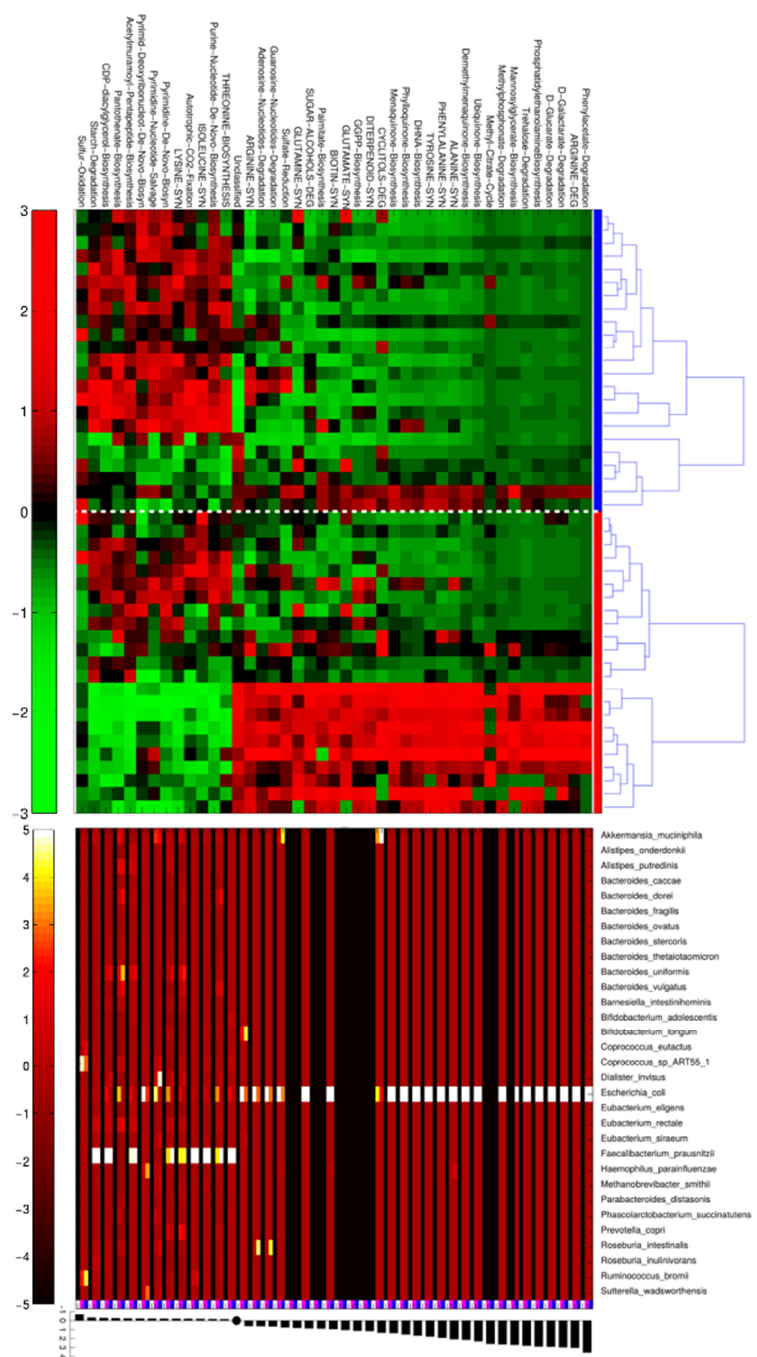
Figure 3. Metagenomic pathways and bacterial genera more expressed with +IMT/+SCA. Heatmap on top shows the MetaCyc L4-pathways statistically different between +IMT/+SCA ( n = 23, red bars at right) and − IMT/ − SCA ( n = 23, blue bar at right) individuals. Normalized and scaled read counts (CPM) per pathway are standardized along rows. Within each experimental group, samples are clustered for similarity using Pearson’s correlation metric and average linkage; the plot in the middle represents the relative contribution of bacterial species to each differential pathway. Values are average CPM calculated for − IMT/ − SCA samples (indicated by the blue square below) and +IMT/+SCA (indicated by the magenta square below). Average CPM values are standardized on a per-column basis (i.e., on pathways), in order to highlight, for each pathway which bacterial taxa contributes most. On the bottom, of the figure, the barplot indicates log2 fold-change between +IMT/+SCA and − IMT/ − SCA average